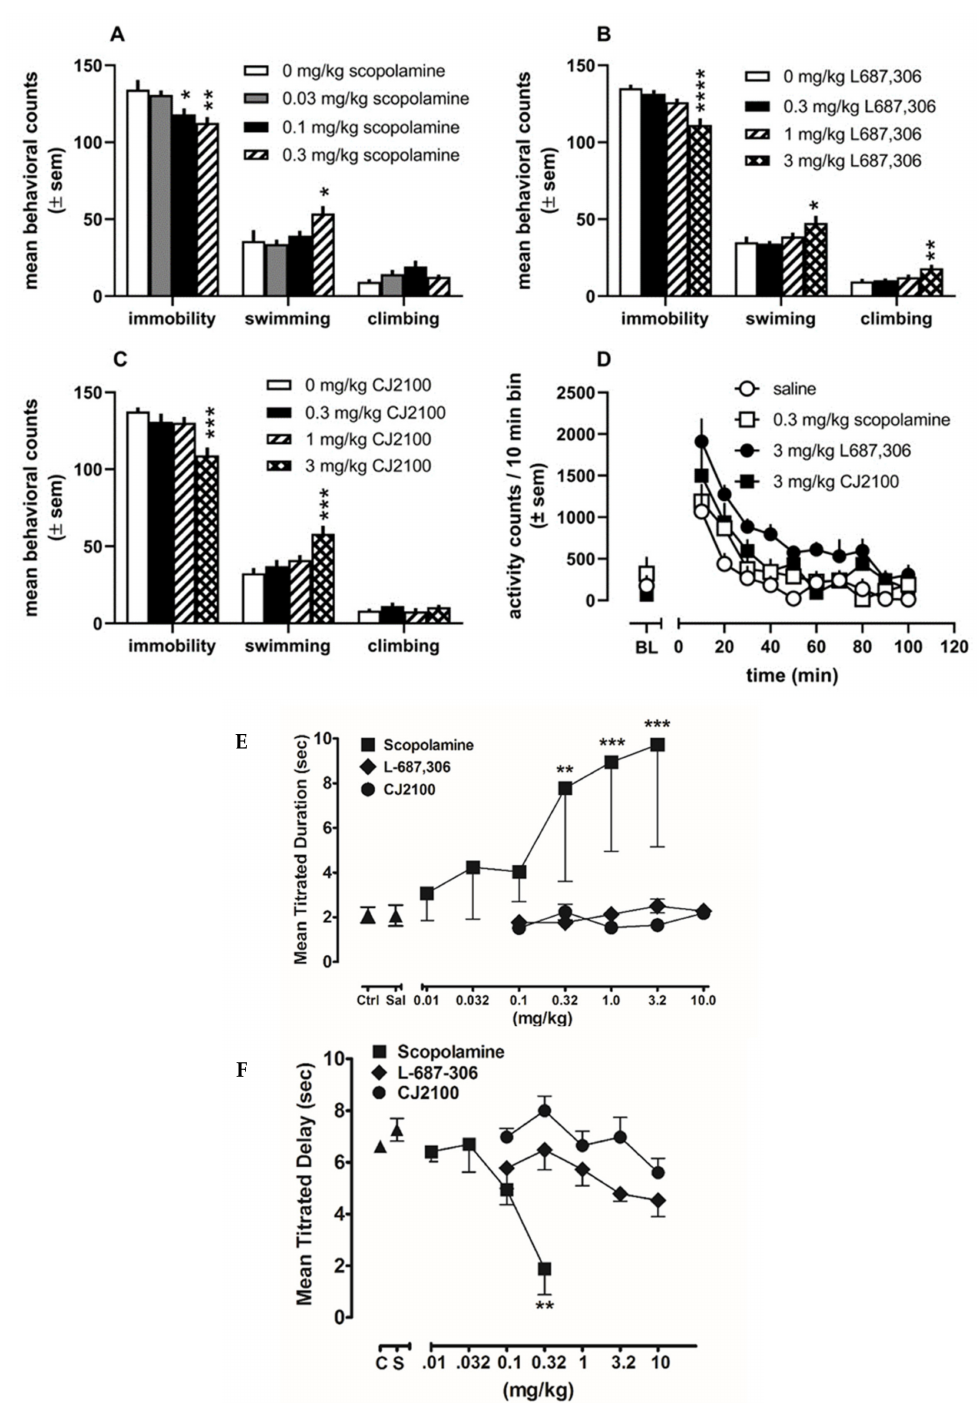
Figure 9. Effects of several doses of Scopolamine ( A ), L-687,306 ( B ), and CJ2100 ( C ) on counts of immobility, swimming, and climbing in the forced swim test. ( D ) Locomotor activity at doses that produced decreases in immobility in the FST. ( E ) Dose-related effects of scopolamine (squares), L- 687,306 (diamonds), and CJ2100 (circles) on mean titrated duration (seconds) in the psychomotor vigilance task. ( F ) Dose-related effects of the compounds on the mean titrated delay (seconds) in the titrating delay matching-to-position task. * p < 0.05, ** p < 0.01, *** p < 0.001, **** p < 0.0001. Reproduced with permission from Johnson CR et al.